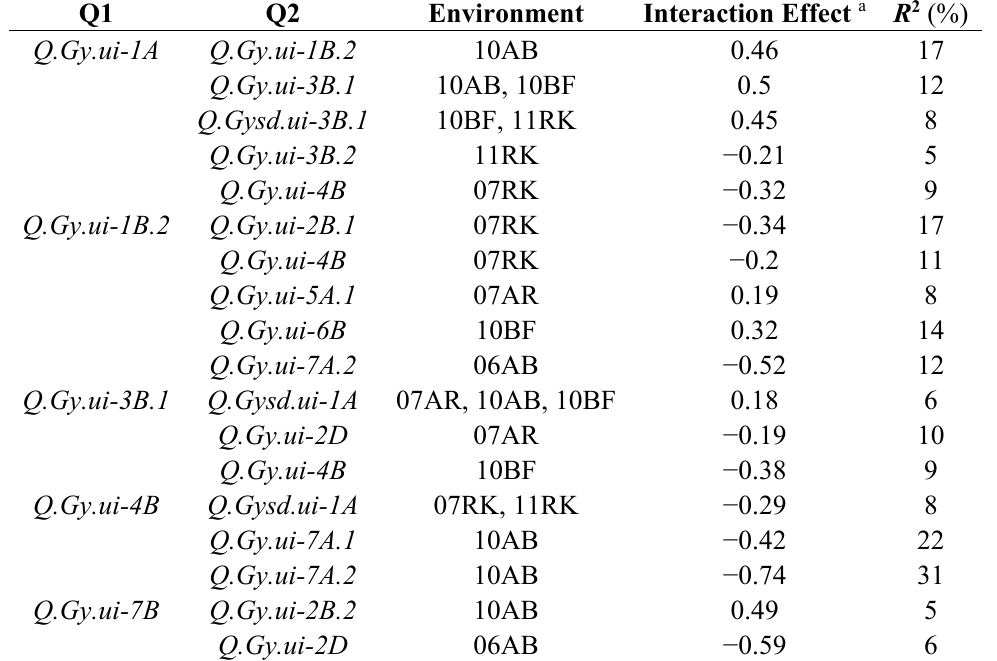
Table 5. QTL × QTL interactions detected in the six trials among Q.Gy.ui-1A , Q.Gy.ui-1B.2 ,